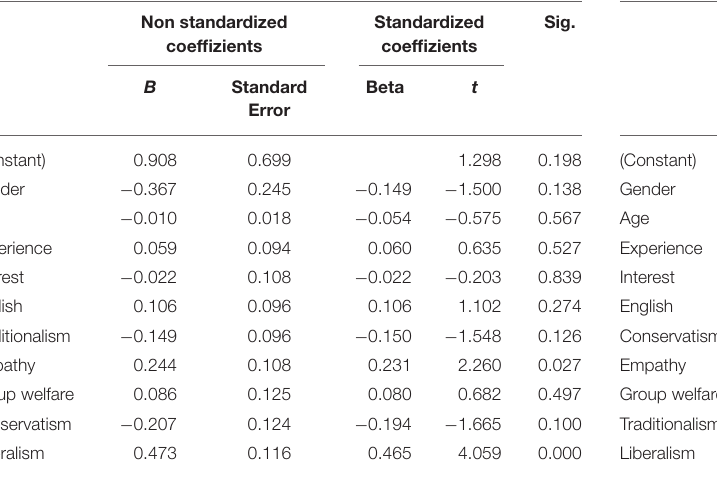
TABLE 4 | Linear regression model predicting the score on “Equality” from the UN-scale in the Cypriot